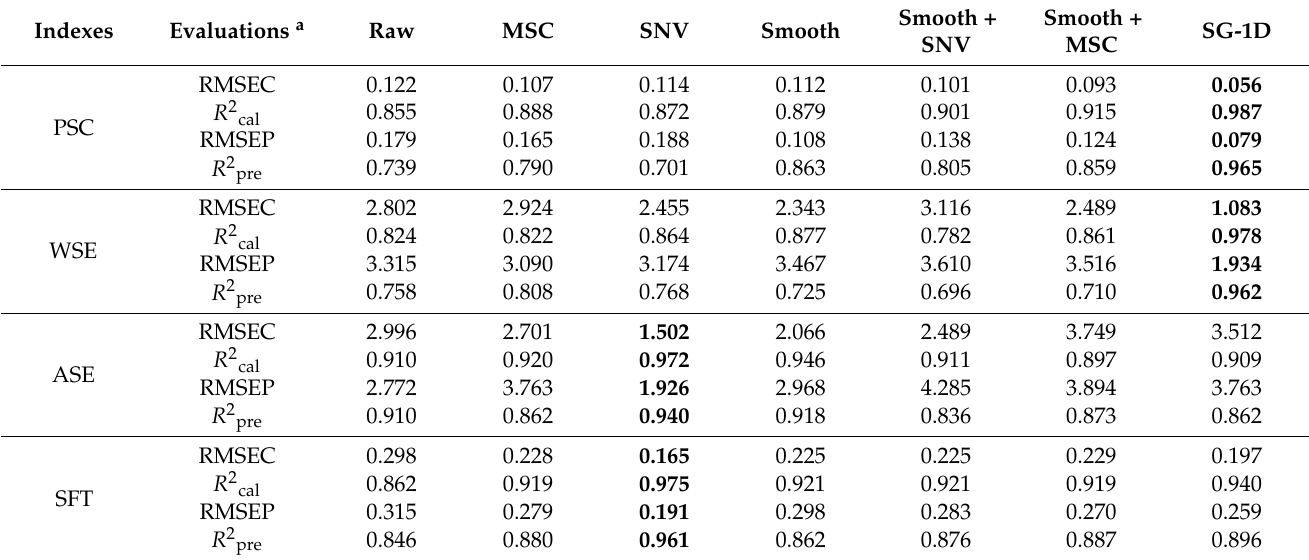
Table 5. Results obtained by using different methods for signal